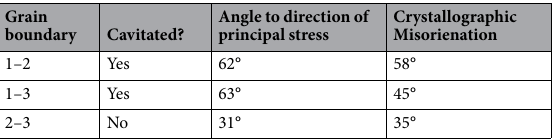
Table 1. Properties of each of the three grain